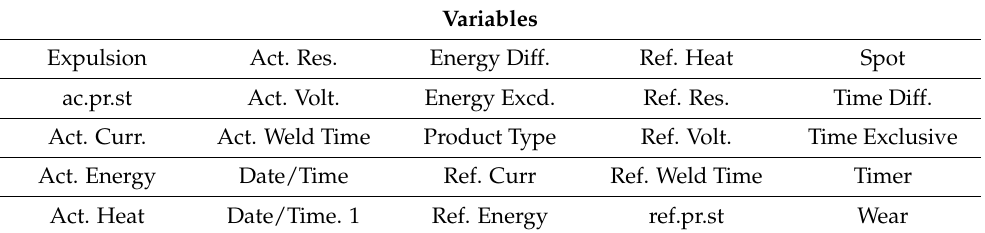
Table 3. Transformed features.